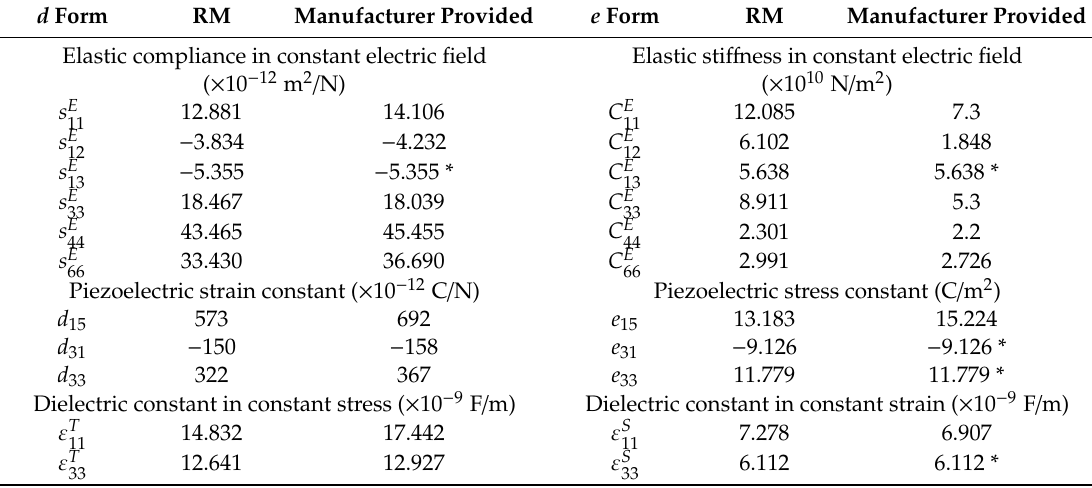
Table 9. Material constant of FUJI C-2 by resonance method and manufacturer. d Form